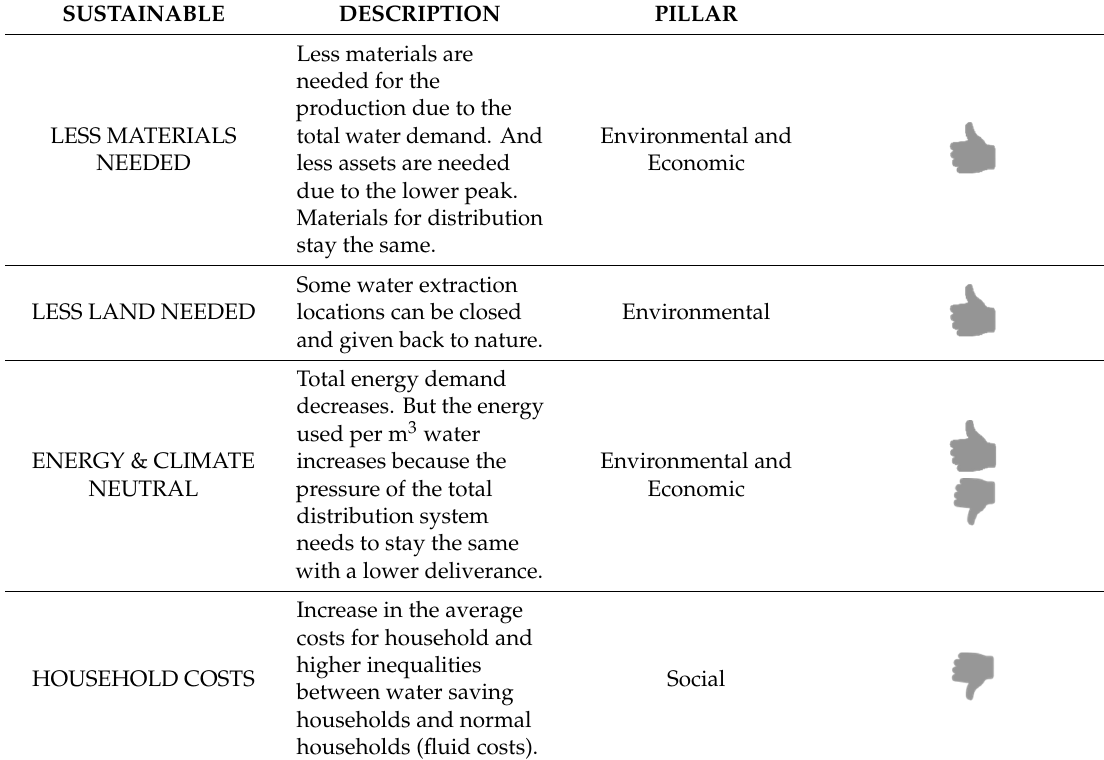
Table 7. Sustainability of centralised system in LF-extreme